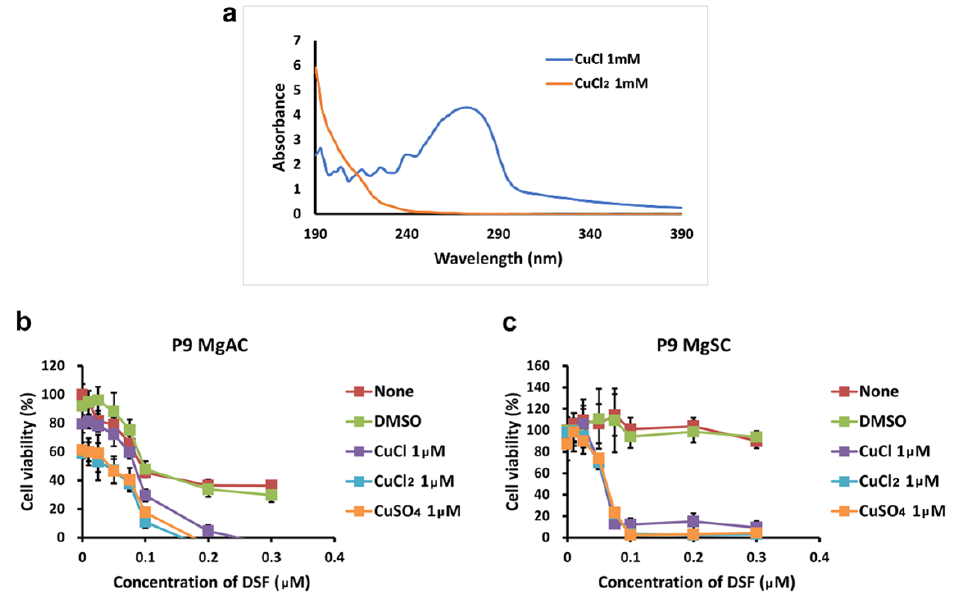
Figure 3. Effect of copper ion valence on the cytotoxicity of the DSF/Cu complex ( a ) UV-visible absorption spectra of CuCl and CuCl 2 in aqueous solution with a concentration of 1 mM. MgACs ( b ) and MgSCs ( c ) were incubated for 48 h with different concentrations of DMSO (0 µ M, 0.01 µ M, 0.025 µ M, 0.05 µ M, 0.075 µ M, 0.1 µ M, 0.2 µ M, and 0.3 µ M) or DSF (0 µ M, 0.01 µ M, 0.025 µ M, 0.05 µ M, 0.075 µ M, 0.1 µ M, 0.2 µ M, and 0.3 µ M) with or without CuCl, CuCl 2 , or CuSO 4 . Cell viability was assessed with MTS assays. Results are presented as the mean ± SD of triplicate samples from representative data from three independent